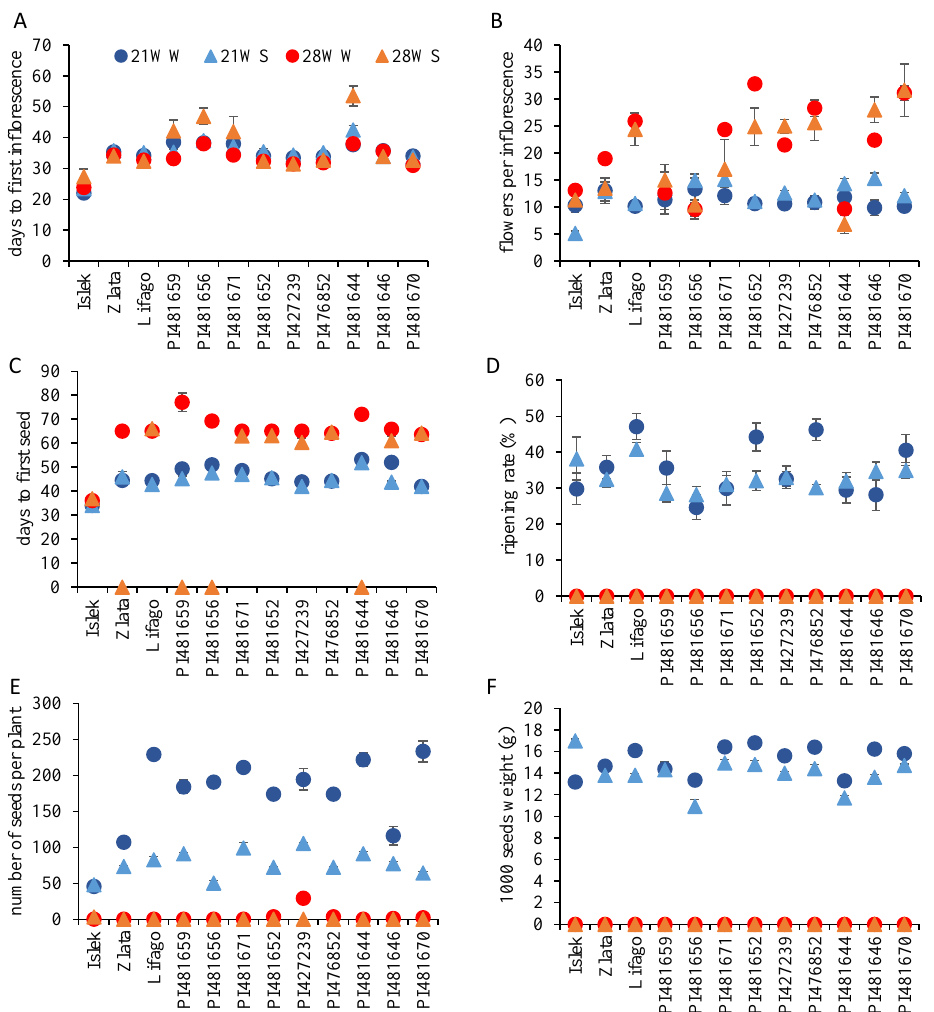
Figure 5. Reproductive growth parameters of F. tataricum varieties subjected to two temperatures (21 ◦ C vs. 28 ◦ C) and water supply conditions (well-watered vs. water-stressed). ( A ) Number of days from sowing to first inflorescence apparition, ( B ) total number of flowers per inflorescence, ( C ) number of days from sowing to apparition of the first green seed on the plant, ( D ) ripening rate (mature seeds per inflorescence/total number of flowers per inflorescence), ( E ) total number of normal seeds per plant, and ( F ) weight of 1000 seeds. 21WW: 21 ◦ C well-watered, 21WS: 21 ◦ C water stress, 28WW: 28 ◦ C well-watered, 28WS: 28 ◦ C water